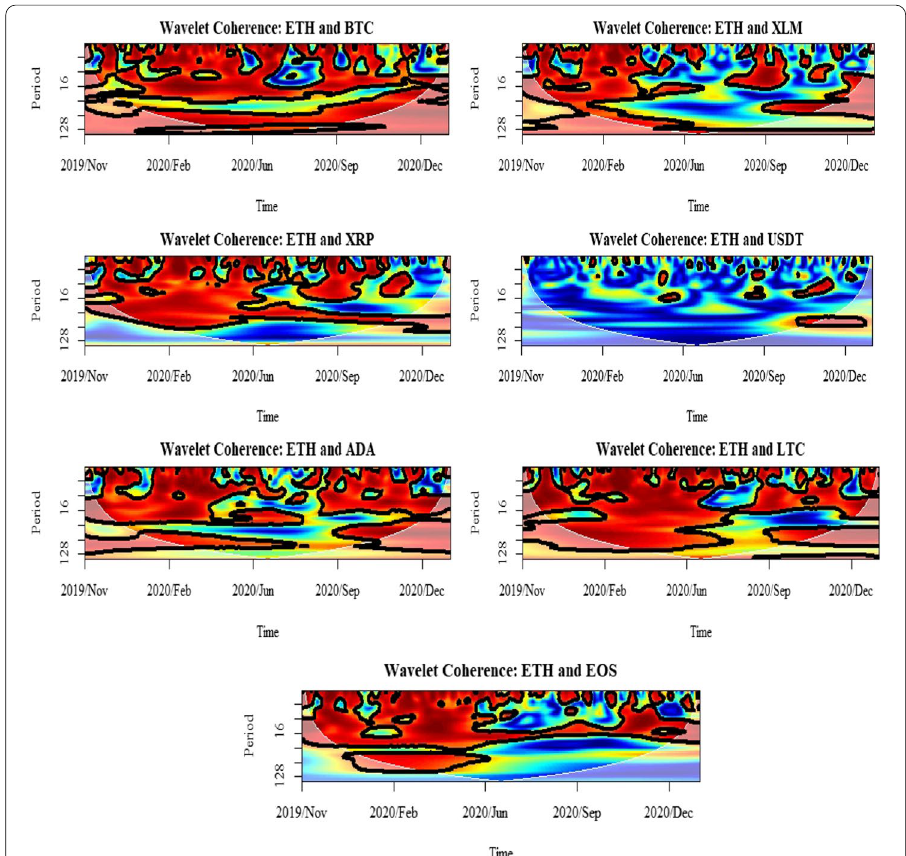
Fig. 7 Results for wavelet coherence: ETH